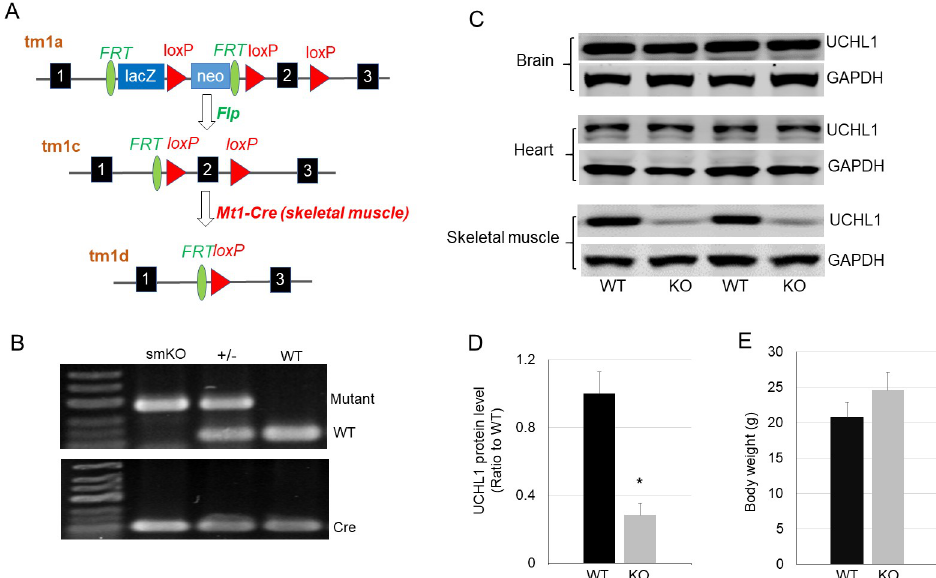
Fig 2. Mouse model of skeletal muscle specific knockout (smKO) of the UCHL1 gene. A : Schematic illustration of strategy of UCHL1 smKO. B : Representative gel image of PCR genotyping. C : Western blot of UCHL1 protein in samples of brain, heart, and skeletal muscles from wild type (WT) or UCHL1 smKO (KO) mice. D : Quantification as a ratio of UCHL1 protein band density in WT vs UCHL1 smKO soleus muscle. � P < 0.05, n = 4. The representative Western blot images were copied from the original membranes scan and each lane was positioned as originally loaded without regrouping. E : Body weight of WT and UCHL1 smKO mice (n = 8).